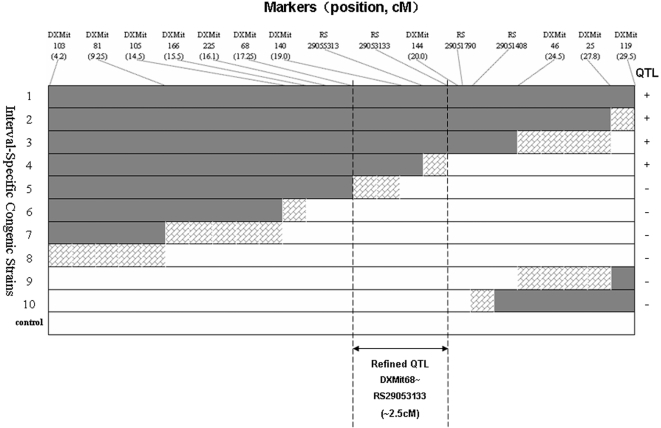
Interval-specific Congenic Strains.The genotype on chromosome X for each of the 10 congenic strains is represented by the horizontal bars. Shaded portions indicate a known homozygous B6 segment, unshaded portions represent a known homozygous C3H segment, and hatched regions depict an area where a crossover between C3H and B6 occurred. The QTL mapped from the F2 linkage analysis extends from dotted lines (17.25–20 cM). The boundary of the refined QTL is shown by the dashed line.